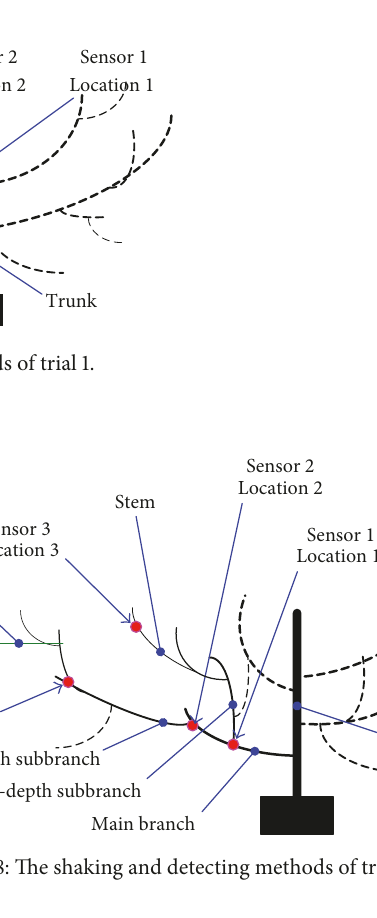
Figure 6: (a) Shaker installed with PVC tine and (b) shaker installed steel tine.